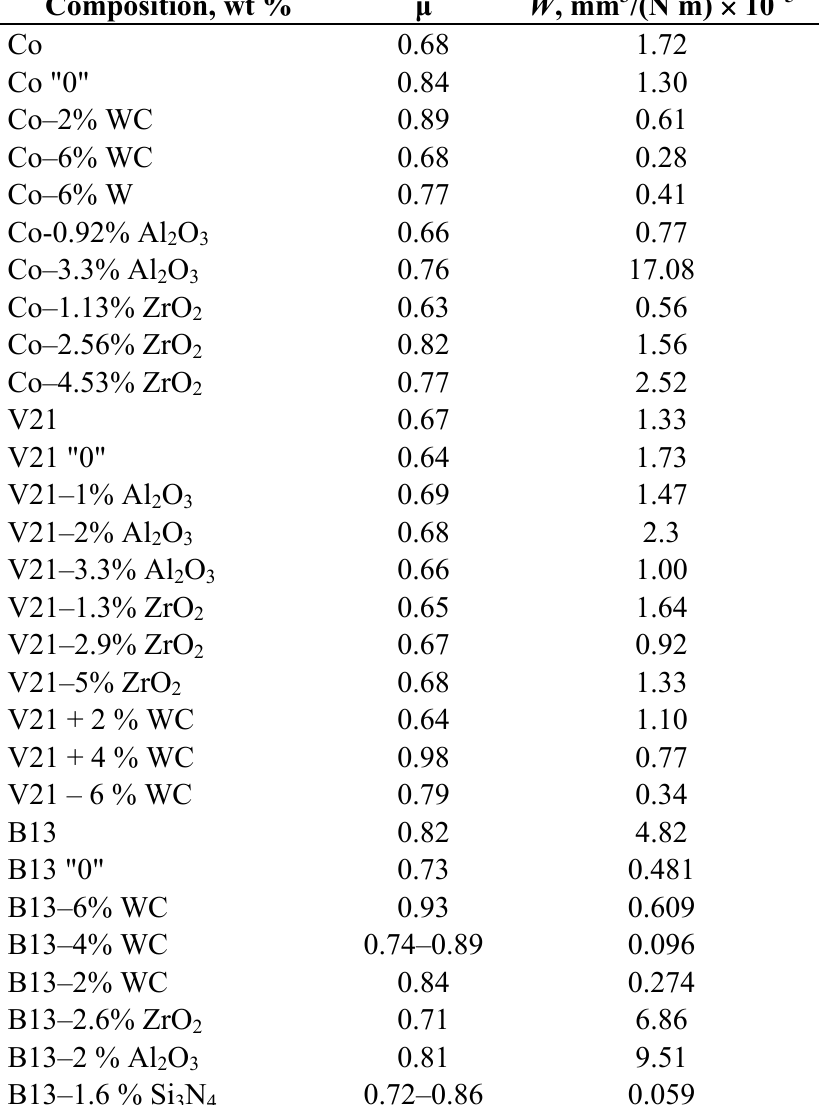
Table 2. Wear resistance ( W ) and friction coefficient ( μ ) of DS